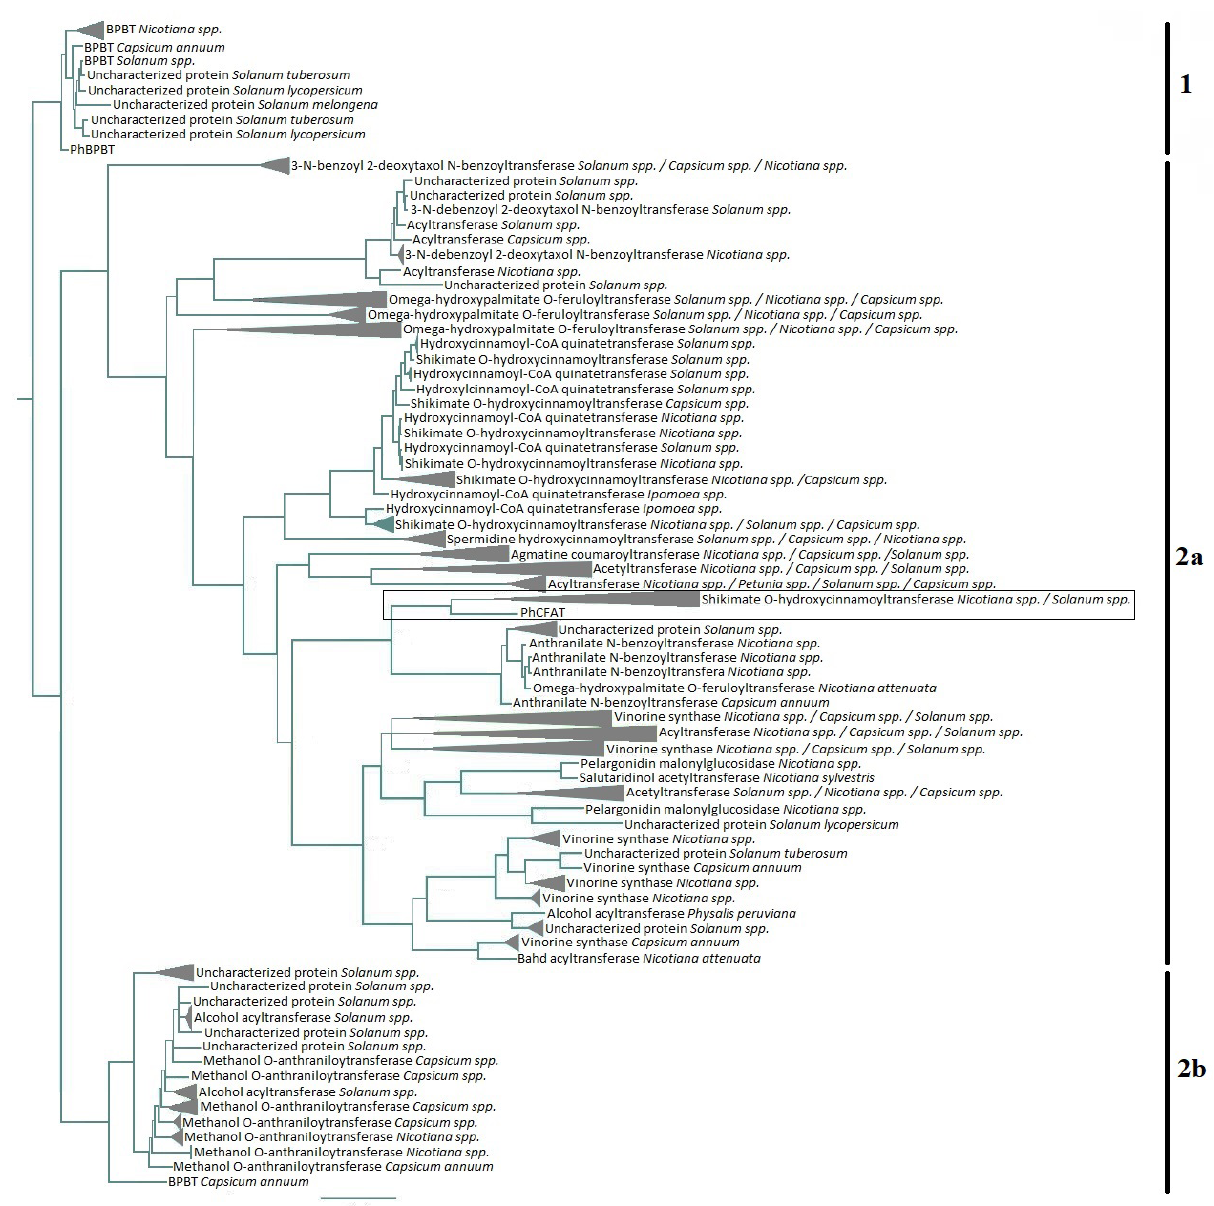
Figure 1 - Solanaceae protein with transferase domain simplified phylogenetic tree generated using Bayesian Inference and JTT + I +G as evolutionary method and model, respectively. The analysis included BPBT and CFAT sequences. Branches with more than one sequence from the same genus were collapsed and indicated with spp . Wider branches indicate PP > 0.80 while narrowed branches had PP < 0.80. The rectangle highlights PhCFAT